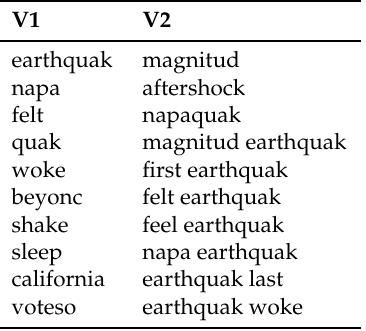
Table 3. Results of the two proposed variants V1 (union vocabulary) and V2 (difference vocabulary) for automatically determining seed words on the earthquake dataset. V1